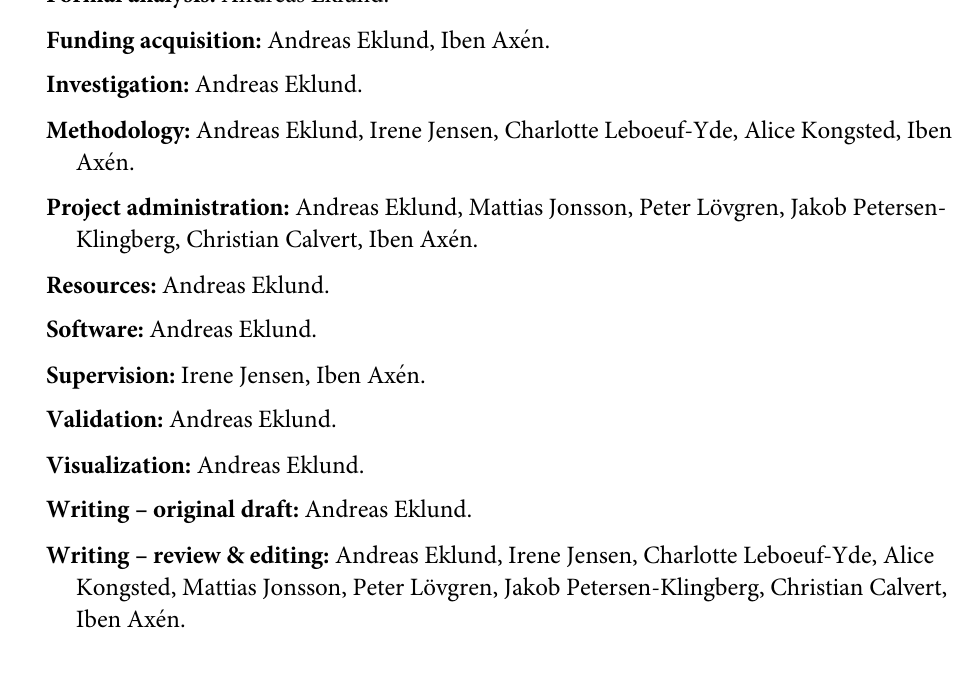
S3 Table. Additional follow-up data. A , no imputation has been made for missing data, mean values and percentages are based on true responses for each variable; MPI, West Haven–Yale Multidimensional Pain Inventory; MC , maintenance care; MOB , mobilization; ACT , mechan- ically assisted spinal manipulative therapy using the activator instrument or similar; DROP , mechanically assisted spinal manipulative therapy using a drop mechanism in table; STT , soft tissue treatment; ATM , use of active therapeutic movement treatment table; SD , standard deviation; n , number of subjects; RMDQ , Roland Morris disability